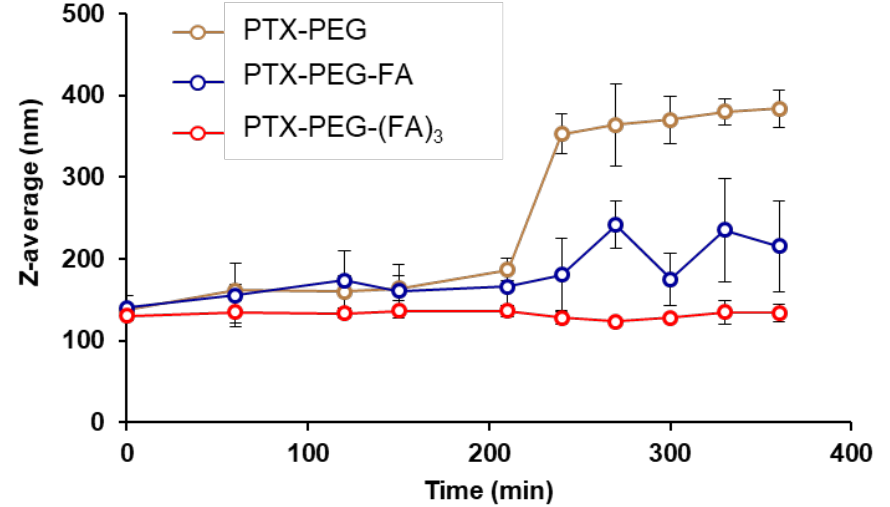
Figure 2. Evaluation of PTX-PEG, PTX-PEG-FA and PTX-PEG-(FA) 3 nanoassemblies stability in PBS buffer at pH 7.4, 37 ◦ C. The size of the micelles was monitored using by DLS.